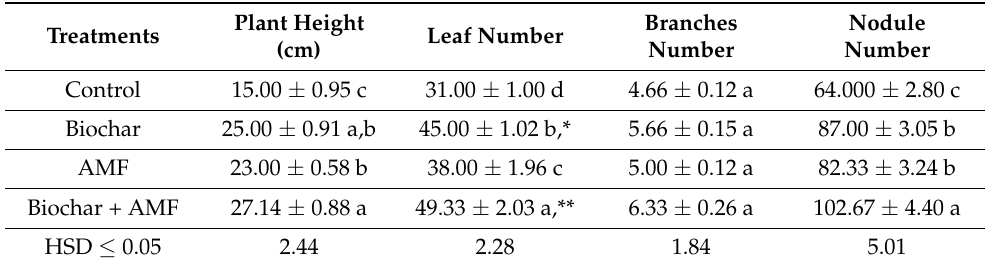
Table 1. Impact of biochar and AMF on plant growth parameters (plant height, leaf, branch and nodule numbers) of